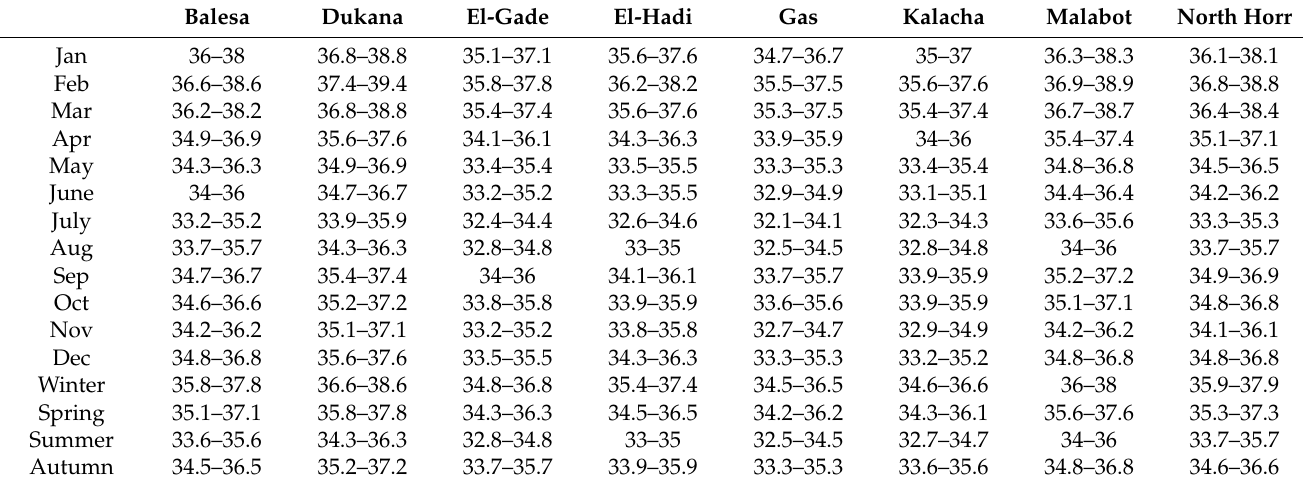
Table 3. Monthly and seasonal 2 ◦ C T MAX ranges centered on the climatological mean and computed for all the eight reference points located in North Horr Sub-County. Values are expressed in ◦ C.